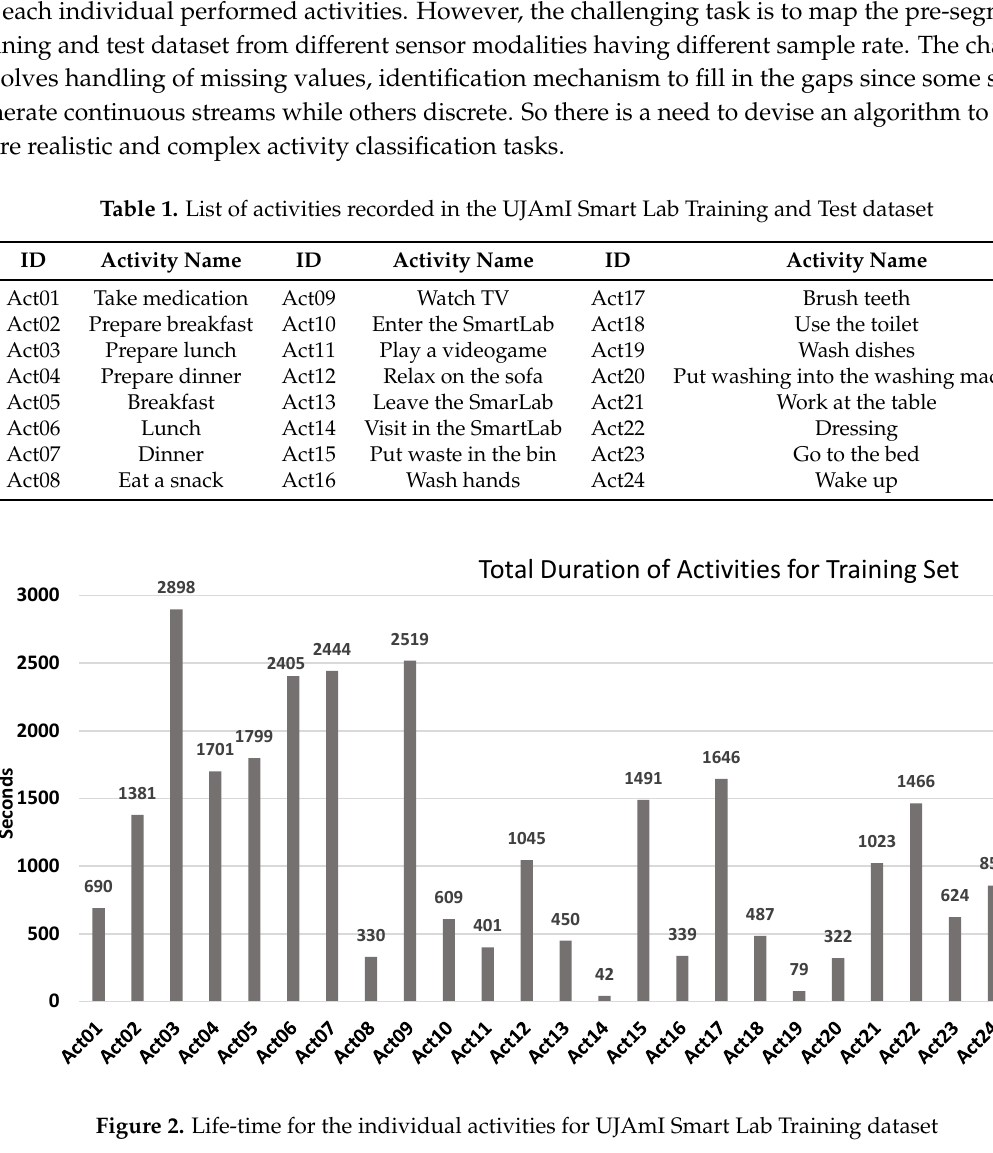
Figure 2. Life-time for the individual activities for UJAmI Smart Lab Training